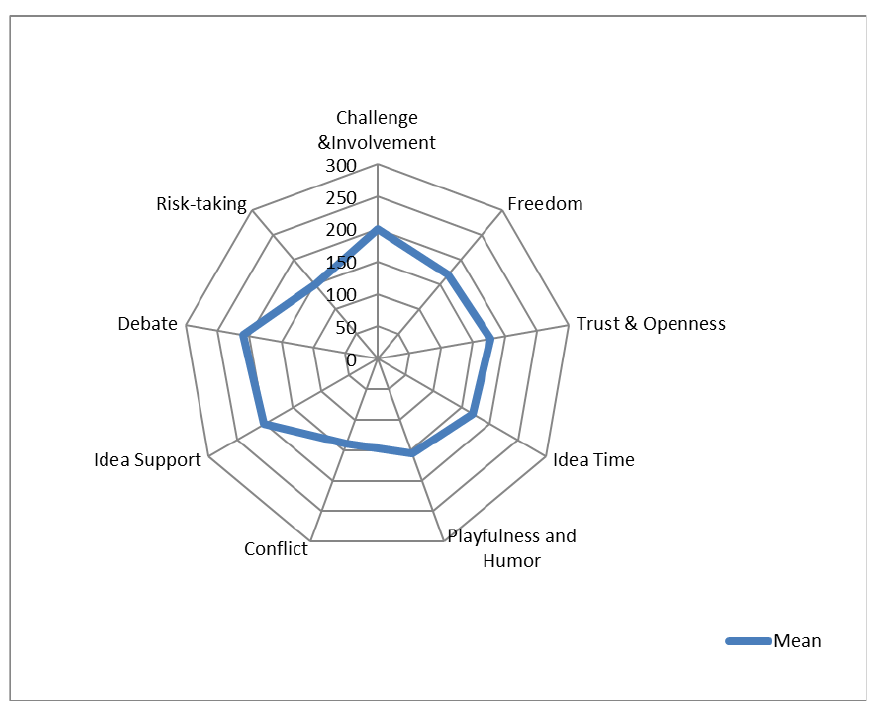
Fig. 2. Assessment of the company’s innovation